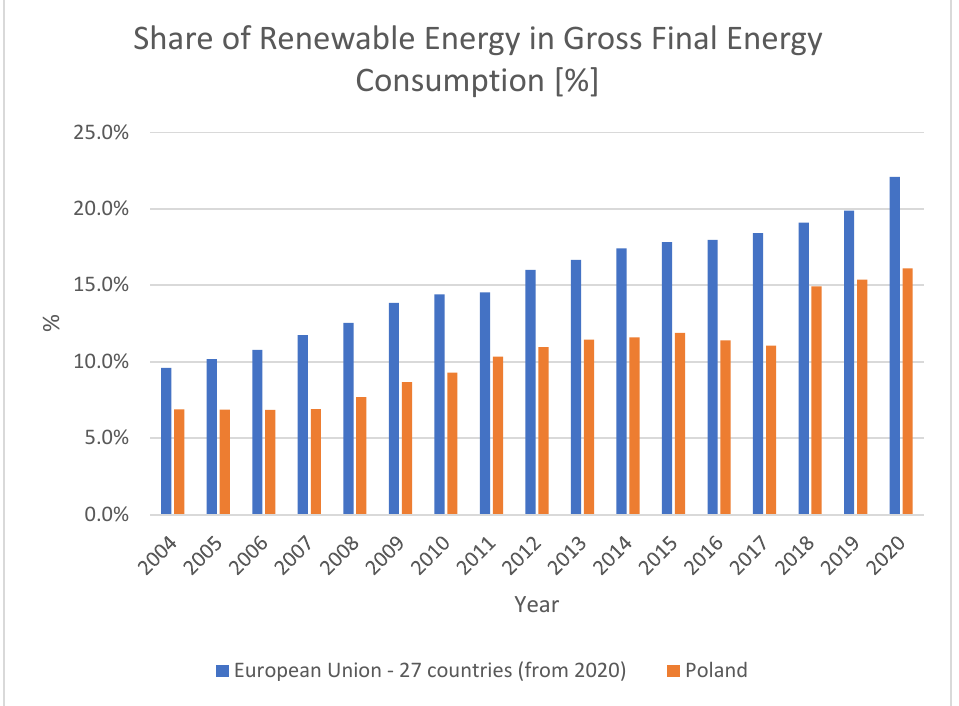
Figure 3. Share of renewable energy in gross final energy consumption (%). Source: Own elaboration based on Eurostat data [22].